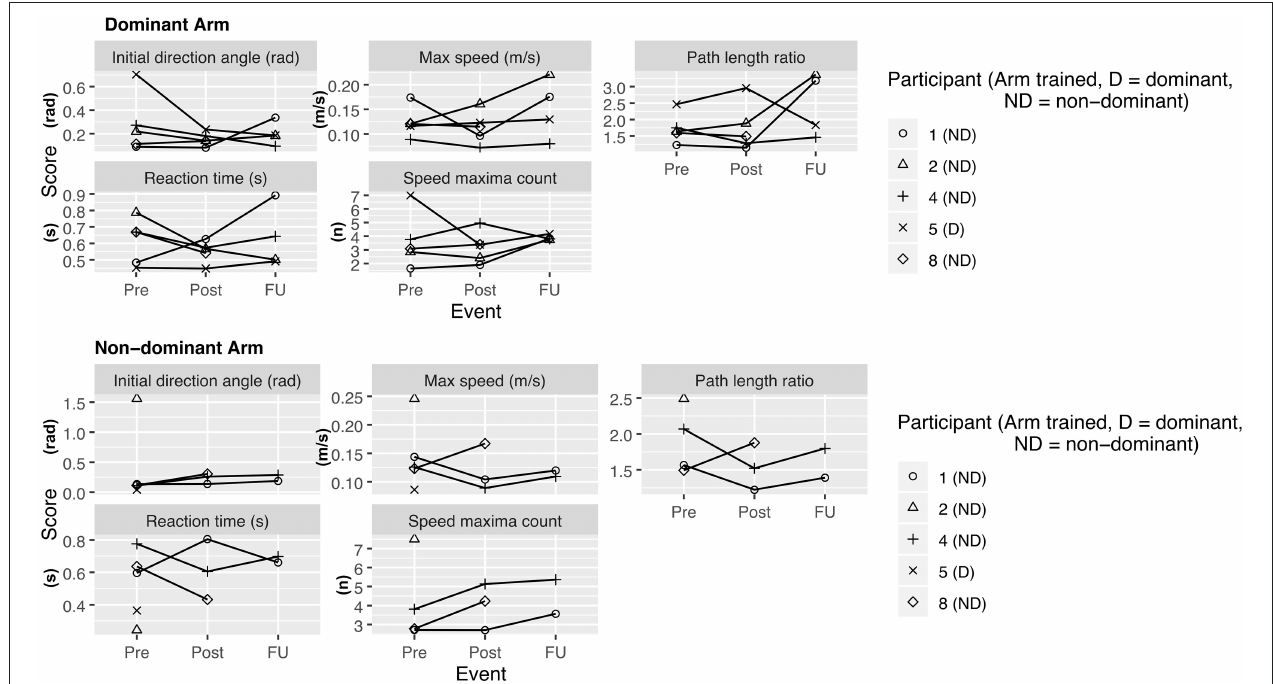
FIGURE 3 | Kinarm assessment—visually guided reaching task. Scores at assessment events Pre ( = before the intervention), Post ( = 1 week after intervention), delayed follow up (FU) ( = 1 month after intervention). Lower values at retest indicate improvement for all variables except for maximum speed, for which an increase is indicative of